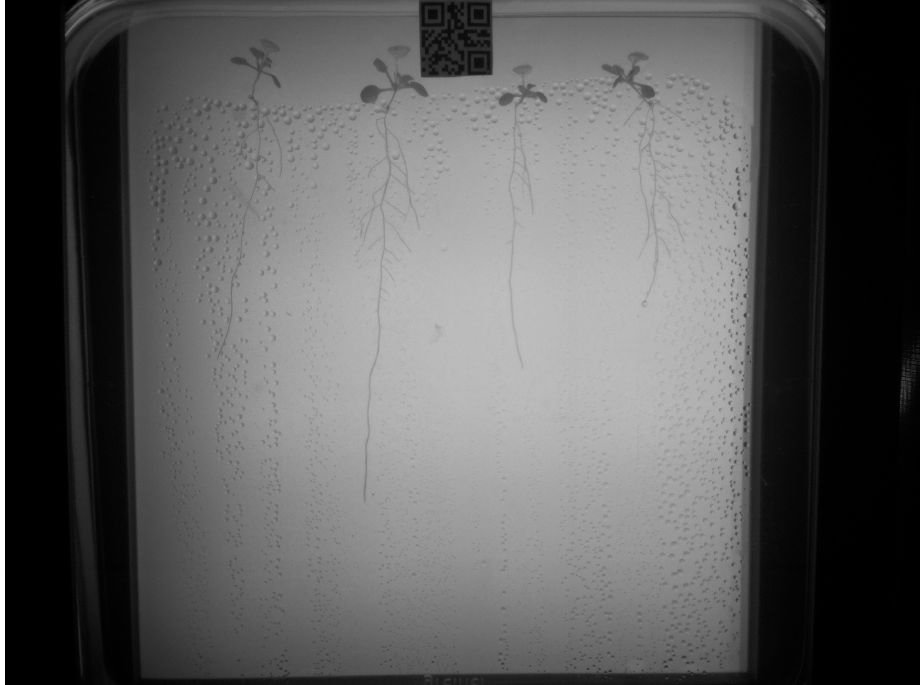
Figure 1. Example of a captured image frame of Arabidopsis thaliana plant growing in a controlled, indoor environment.